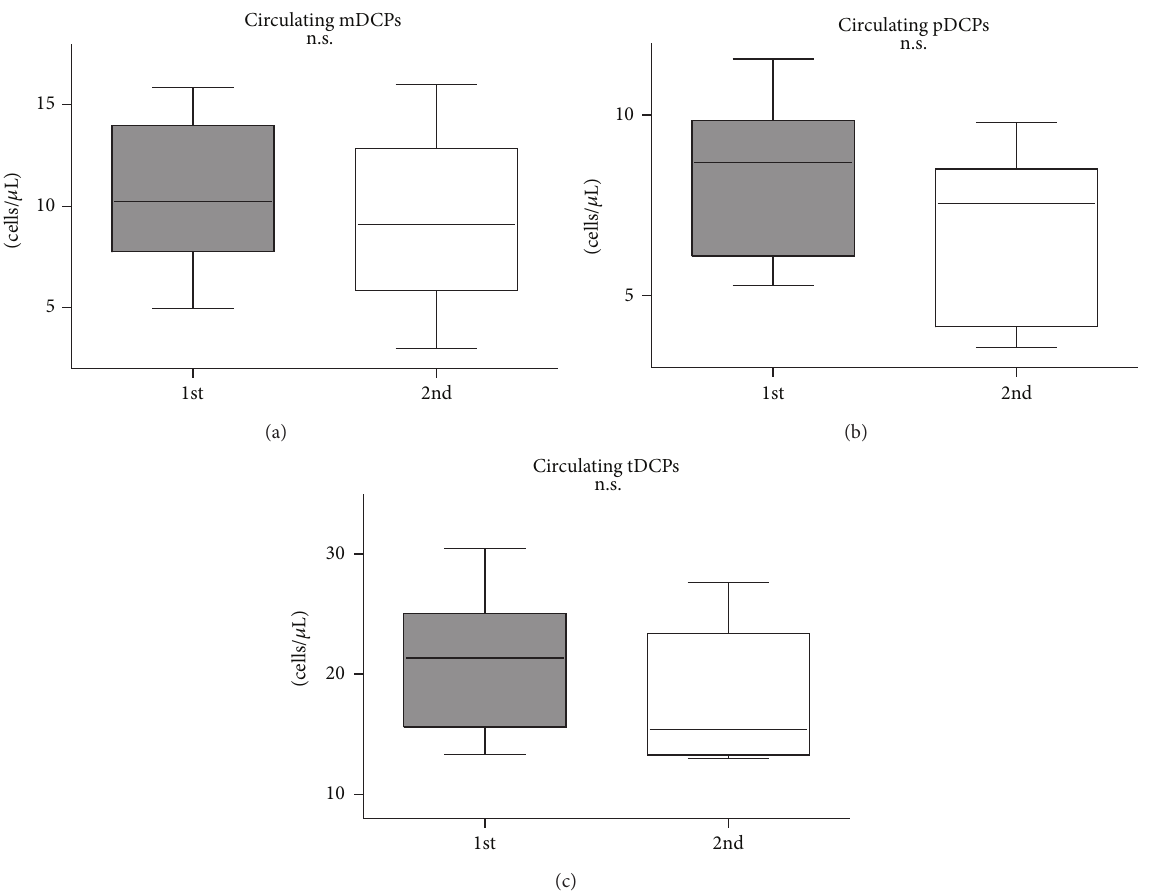
Figure 3: Follow-up frequency of circulating mDCPs, pDCPs, and tDCPs in patients with PAD compared with initial measurement. Absolute numbers of circulating mDCPs (a), pDCPs (b), and tDCPs (c) (cells/ 𝜇 L) are shown. The box plots indicate the median (line inside the